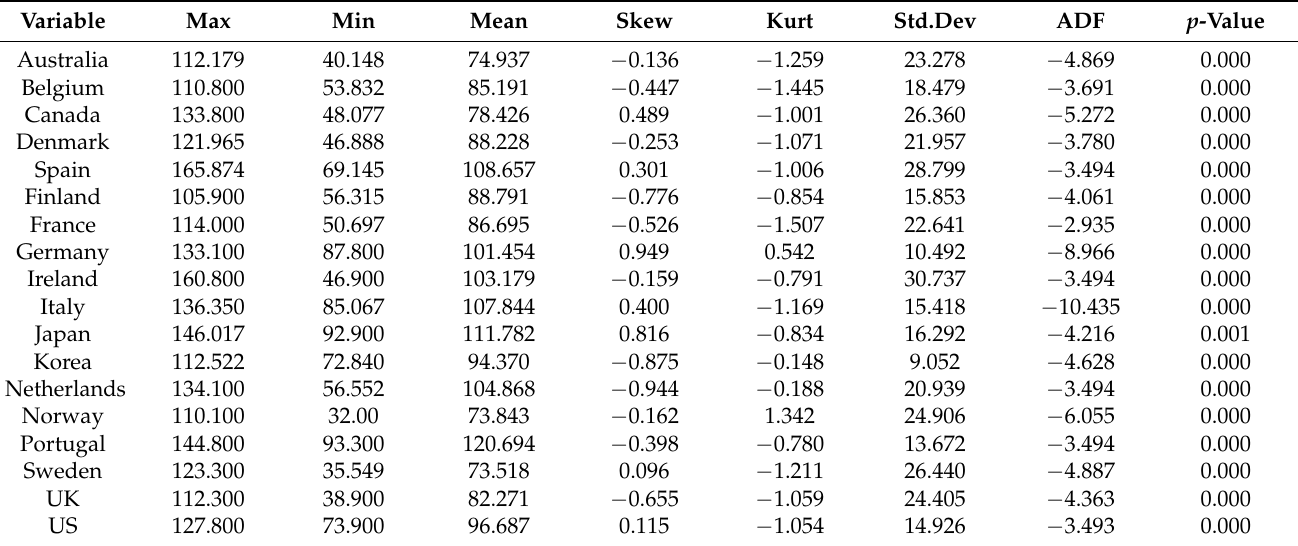
Table 2. Descriptive statistics of the housing price index of OECD